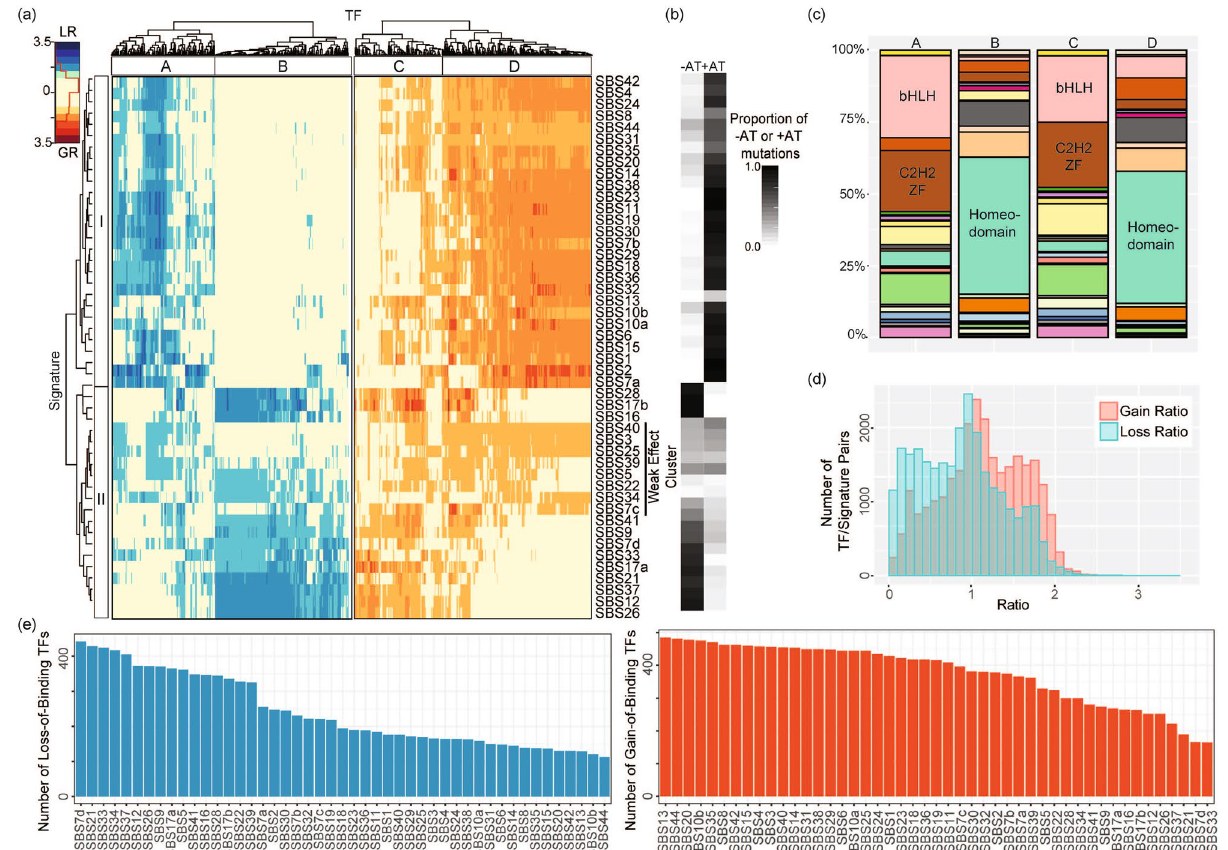
Figure 3. Overview of mutational signatures’ effects on TF binding affinity. ( a ) Heatmap of GRs and LRs for 582 human TFs (columns) and 47 mutational signatures (rows). Both dimensions were grouped by the R hclust function using unsupervised hierarchical clustering with complete linkage on Euclidean distance. ( b ) The proportions of mutations in each signature that mutate cytosine or guanine to adenine or thymine (labelled "+ AT") or vice-versa (labelled "–AT"). Each row corresponds to a signature labelled in ( a ). ( c ) Binding-domain classes within each TF cluster in ( a ). Most frequently affected classes in each cluster are labelled. bHLH, basic helix-loop-helix; C2H2 ZF, C2H2-zinc finger. Additional details in Figure S1 and Table S4. ( d ) Histograms of GRs and LRs for all pairs of TFs and mutational signatures. ( e ) The numbers of gain- and loss-of-binding TFs for each of the 47 mutational